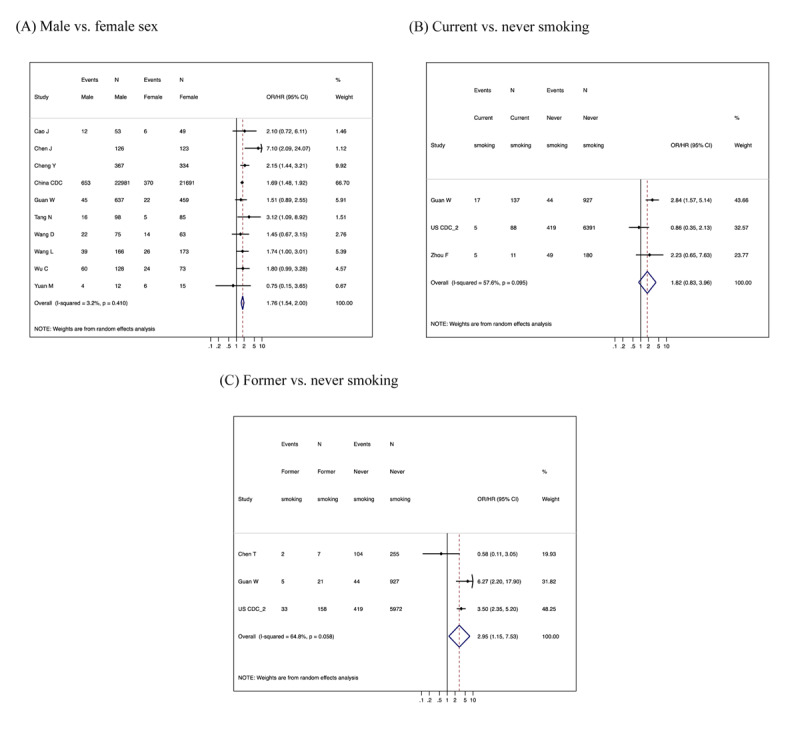
Forest plots of unadjusted relative risk estimates of severe COVID-19 according to gender (A), smoking status (B) and (C) based on restrictive meta-analysis.